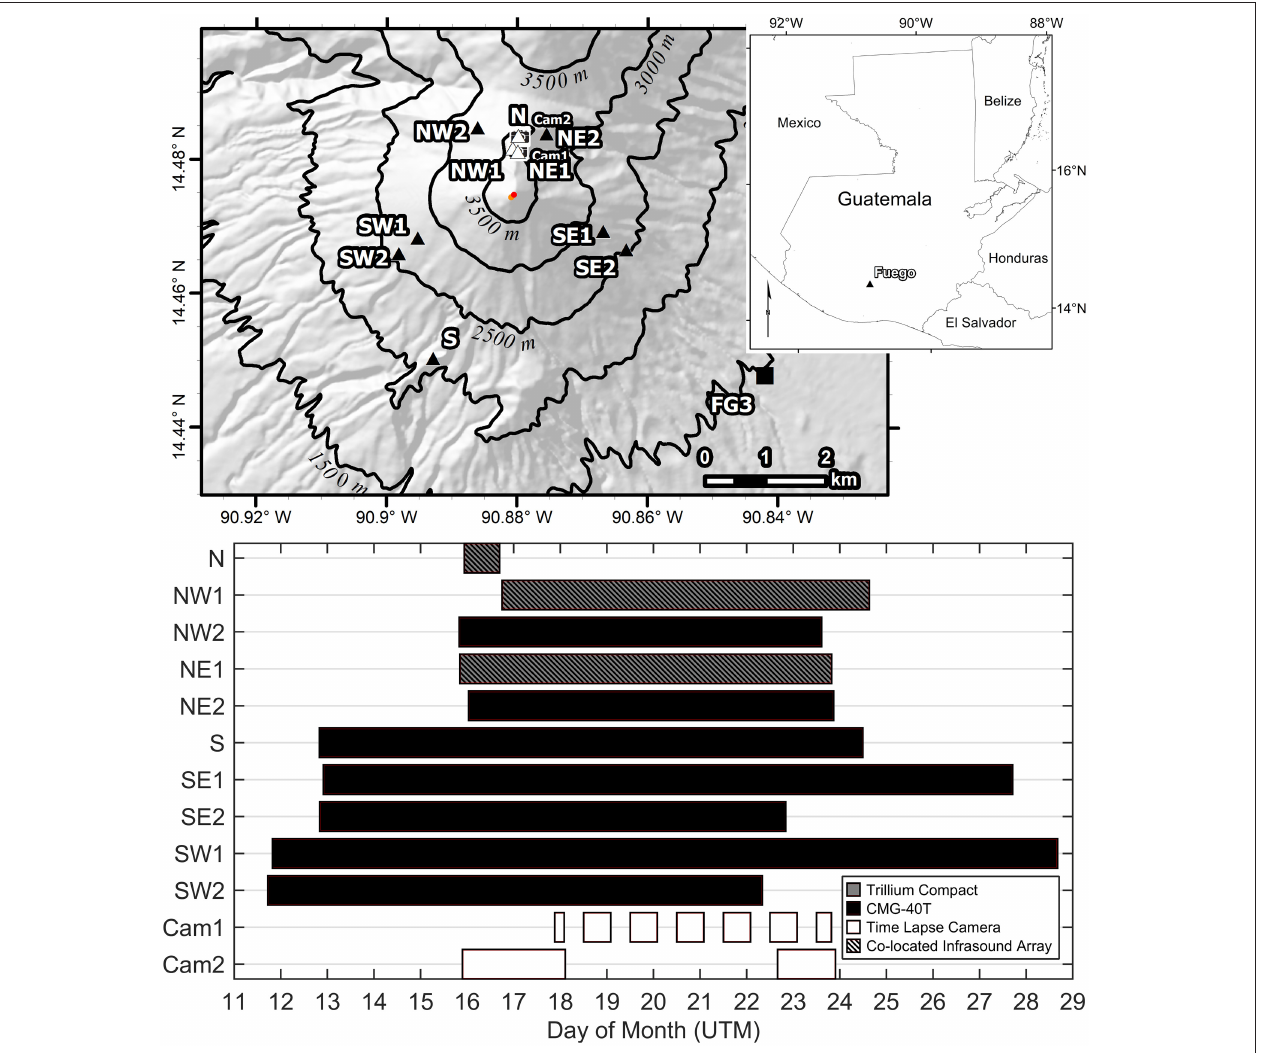
FIGURE 1 | January 2012 locations and operational times of equipment. (A) Shows a map location of Fuego volcano in Guatemala. A larger-scale view of Fuego with the locations of the time-lapse cameras and seismic stations is shown in (B) . White triangles mark the location of the Trillium Compact instruments and black triangles indicate Guralp CMG-40T instruments. The black square represents the permanent short period FG3 station operated by INSIVUMEH. Cam1 and Cam2 mark the locations of the time-lapse cameras. The approximate location of the summit vent is shown in red and the approximate location of the flank vent is shown in orange. Contour intervals are 500m. The operational times of the stations and time-lapse cameras are shown in (C) .